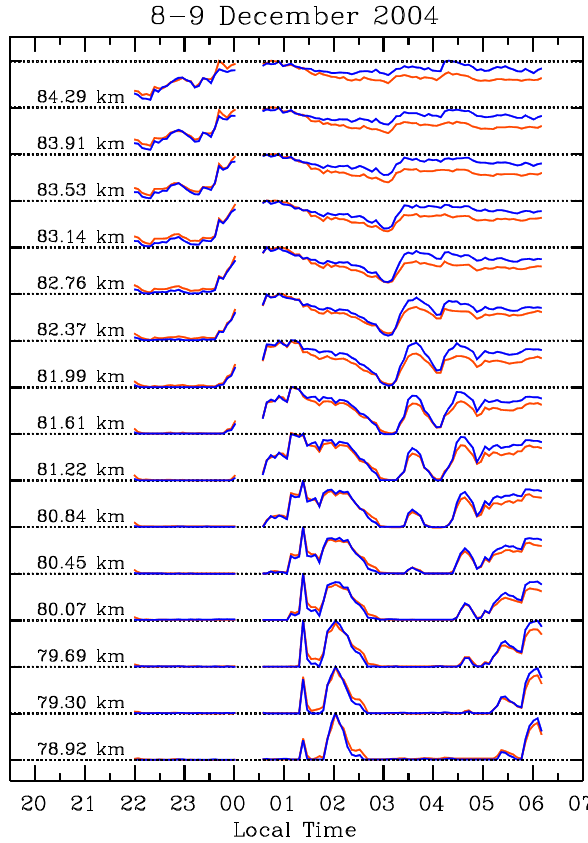
Fig. 9. Time variations of relative densities for Na (orange line) and Fe (blue line) observed at altitudes between 78.92 and 84.29km (plotted in every 4 altitude bins) during the night of 8–9 Decem- ber 2004, which display altitude dependence of the Na and Fe time variation relations in detail. Note that the temporal variations of the Na and Fe relative densities show an excellent similarity on the bot- tommost layer underside, and difference occurs at higher altitudes.